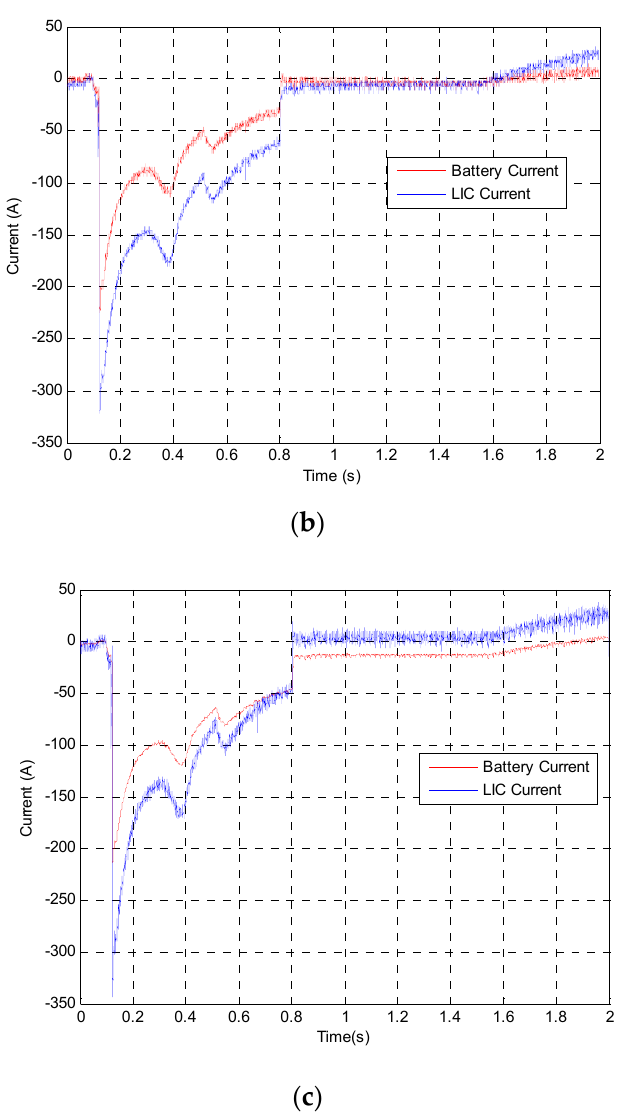
Figure 8. Balanced parallel connection: ( a ) connection diagram; ( b ) test results; ( c ) simulation results.